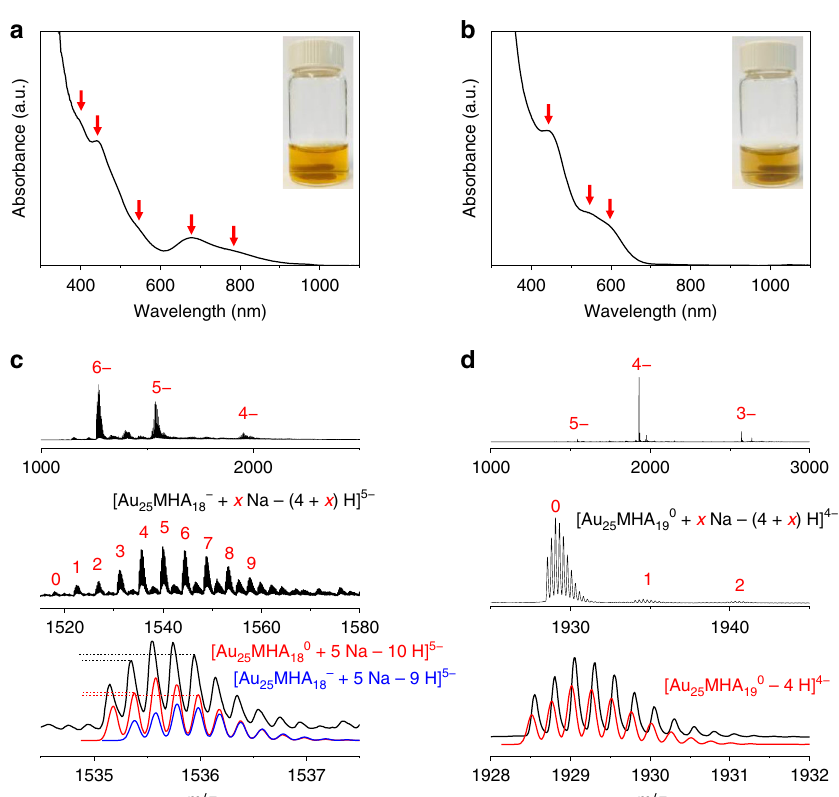
Fig. 2 Characterization of the Au 25 species. UV-Vis absorption spectra of as-prepared ( a ) [Au 25 MHA 18 ] – and ( b ) [Au 25 MHA 19 ] 0 . Insets show the digital images of the solution of corresponding species. Red arrows indicate the positions of characteristic absorption peaks. ESI-MS spectra of ( c ) [Au 25 MHA 18 ] – and ( d ) [Au 25 MHA 19 ] 0 . Both experimental and simulated spectra are shown. Dash lines in c are guidelines to judge the relative intensity of corresponding isotopic peaks. The discrepancy between the experimental and simulated result indicate the co-existence of [Au 25 MHA 18 ] – and [Au 25 MHA 18 ] 0 .